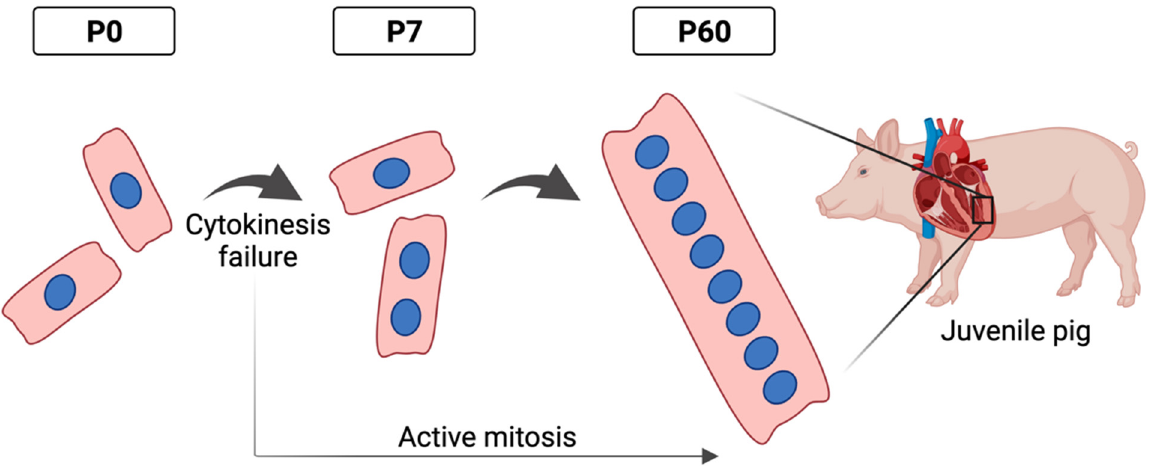
Figure 1. Schematic of transition to predominantly multinucleated cardiomyocyte state during postnatal development in swine. Juvenile pigs exhibit 4 to 16 nuclei per cardiomyocyte.